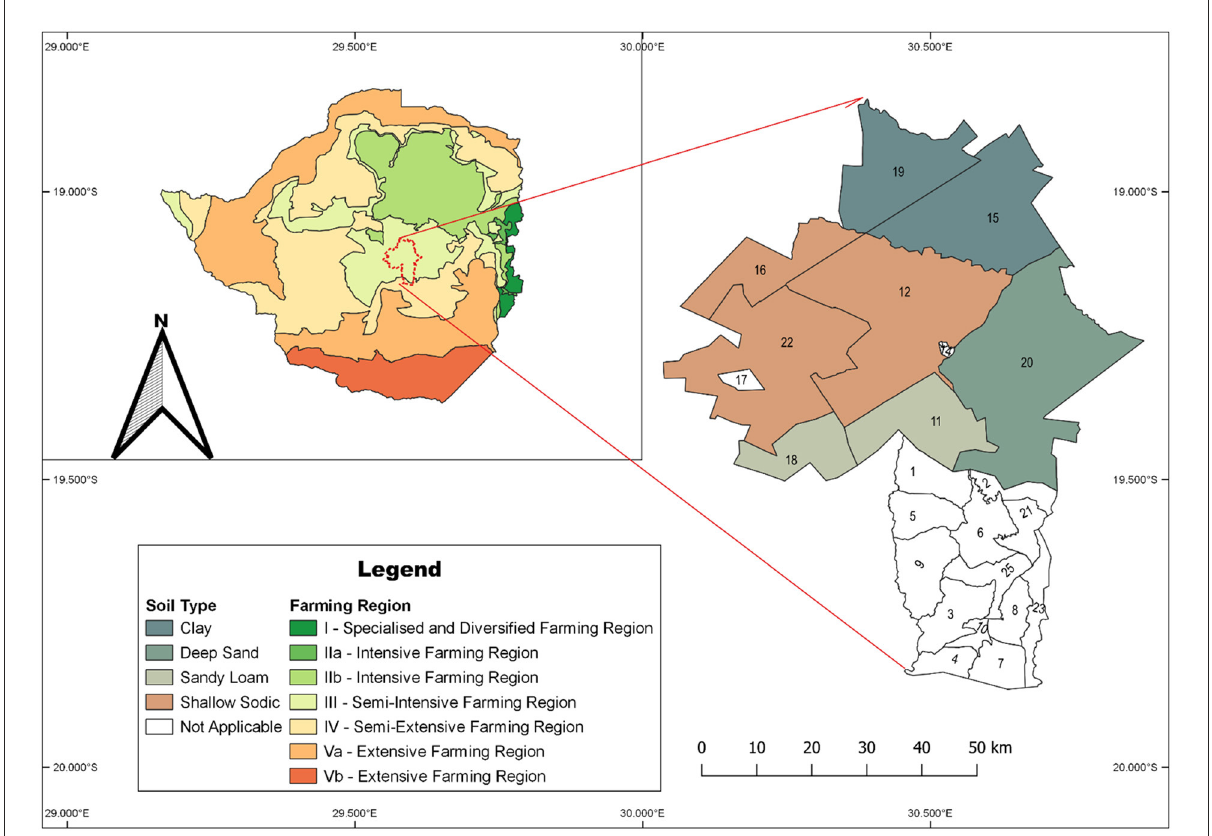
FIGURE1 Map of Chirumanzu, Zimbabwe showing the location of the study area. Source: Author’s graphical representation of the study